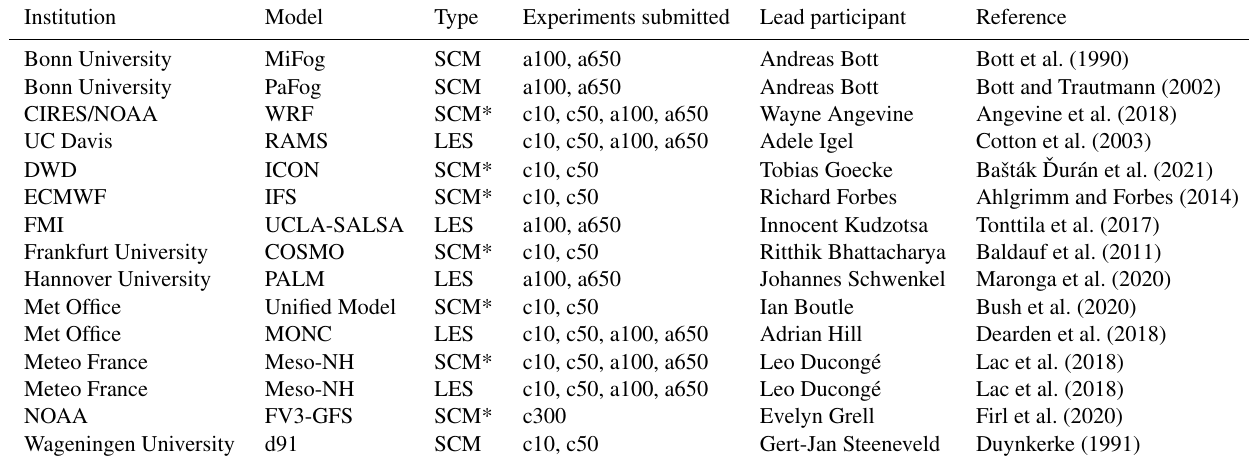
Table 1. Modelling centres, lead participants, models, and model simulations submitted. The * denotes the SCMs that have the physics package and vertical resolution of operational NWP models.